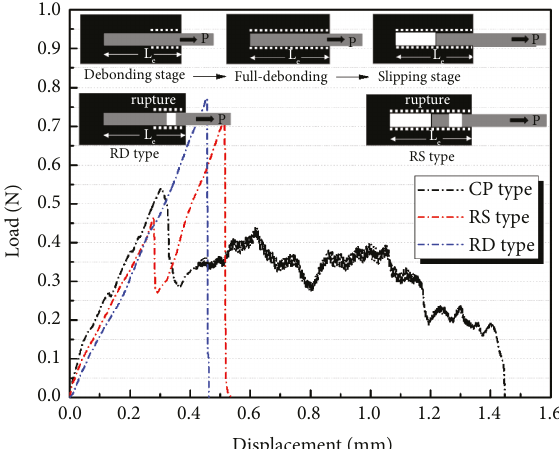
Figure 1: Typical pullout behavior curves of PVA fiber.